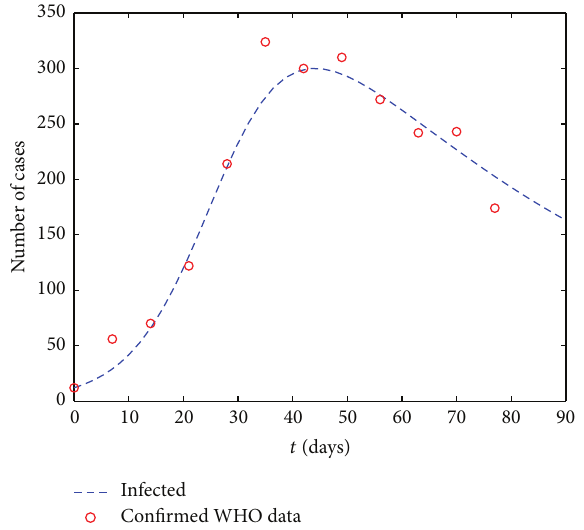
Figure 2: Graph of infected 𝐼(𝑡) obtained from (4) with 𝛽 = 0.000318 , 𝜇 = 0.0175 , 𝑆(0) = 460 , 𝐼(0) = 12 , and 𝑅(0) = 0 versus the real data of confirmed cases for the 2014 Ebola outbreak occurred in Liberia from July 14 (day 𝑡 = 0 ) and October 12, 2014 (day 𝑡 = 90 ).